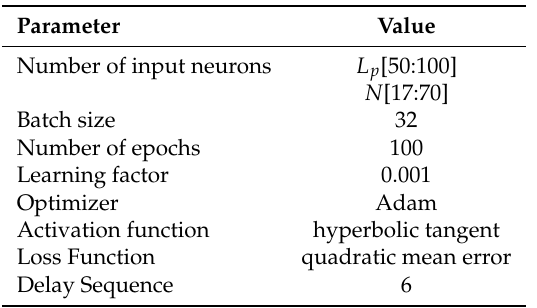
Table 2. Optimal parameters for LSTM execution